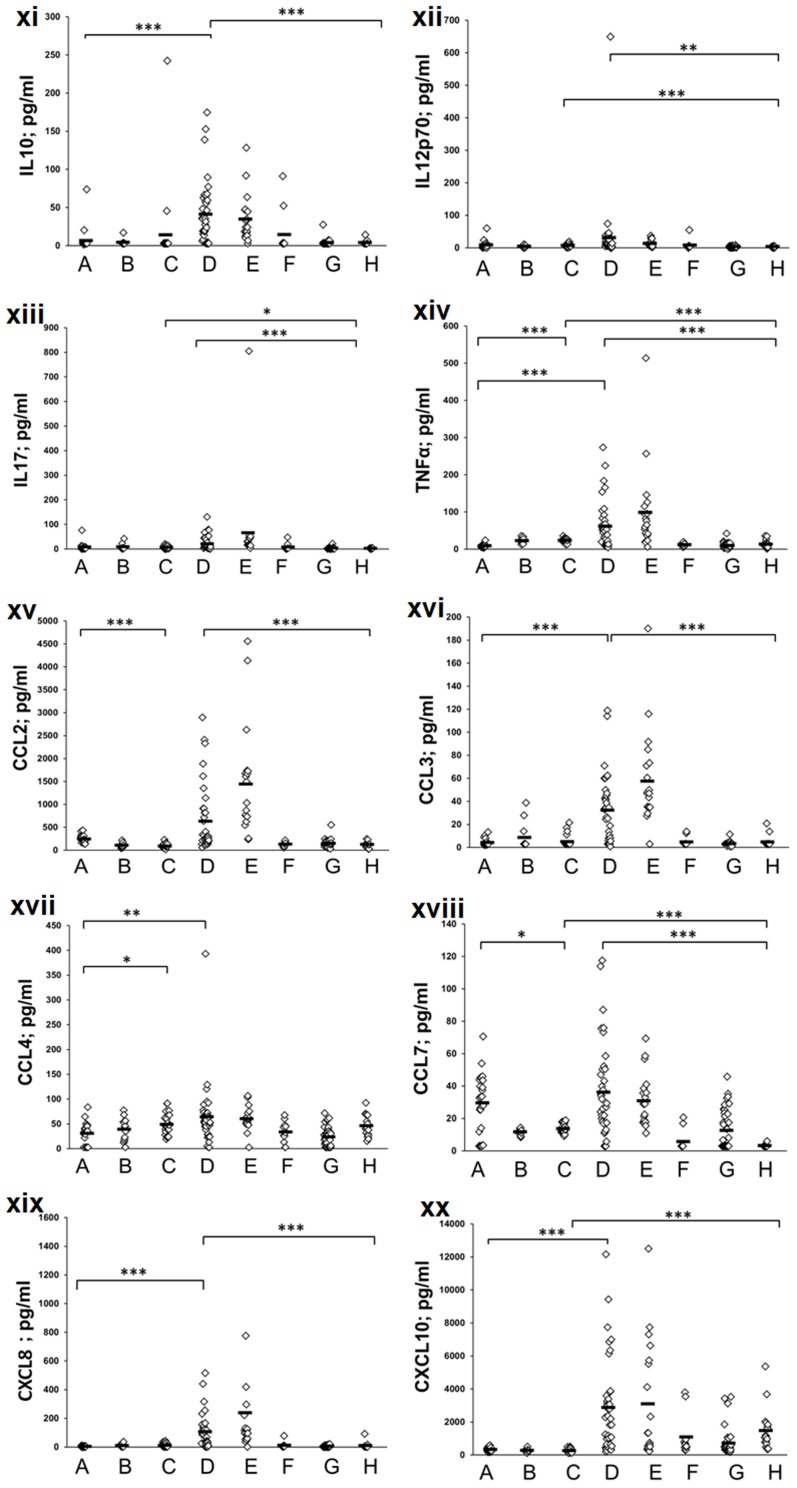
Mean cytokine levels (pg/ml) in the plasma of study subjects belonging to different categories.(A = non-pregnant controls, B = control-pregnant trimester1, C = control-pregnant trimester-2+3, D = acute non-pregnant patients, E = convalescent non-pregnant patients, F = subclinical pregnant trimester 1, G = subclinical pregnant trimester-2+3, H = acute pregnant trimester-2+3 patients). p values are indicated by stars, *p<0.007, **p<0.001, ***p<0.0001.